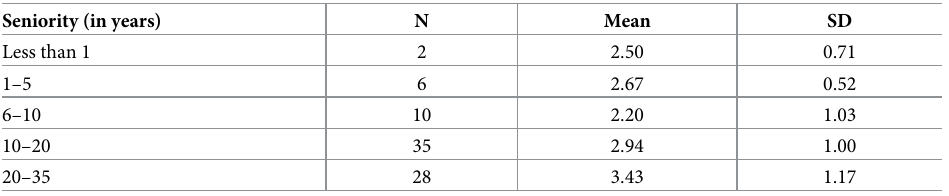
Table 2. One-way ANOVA for differences in professional experience in the organization and the frequency of knowledge management and departmental attention. Seniority (in